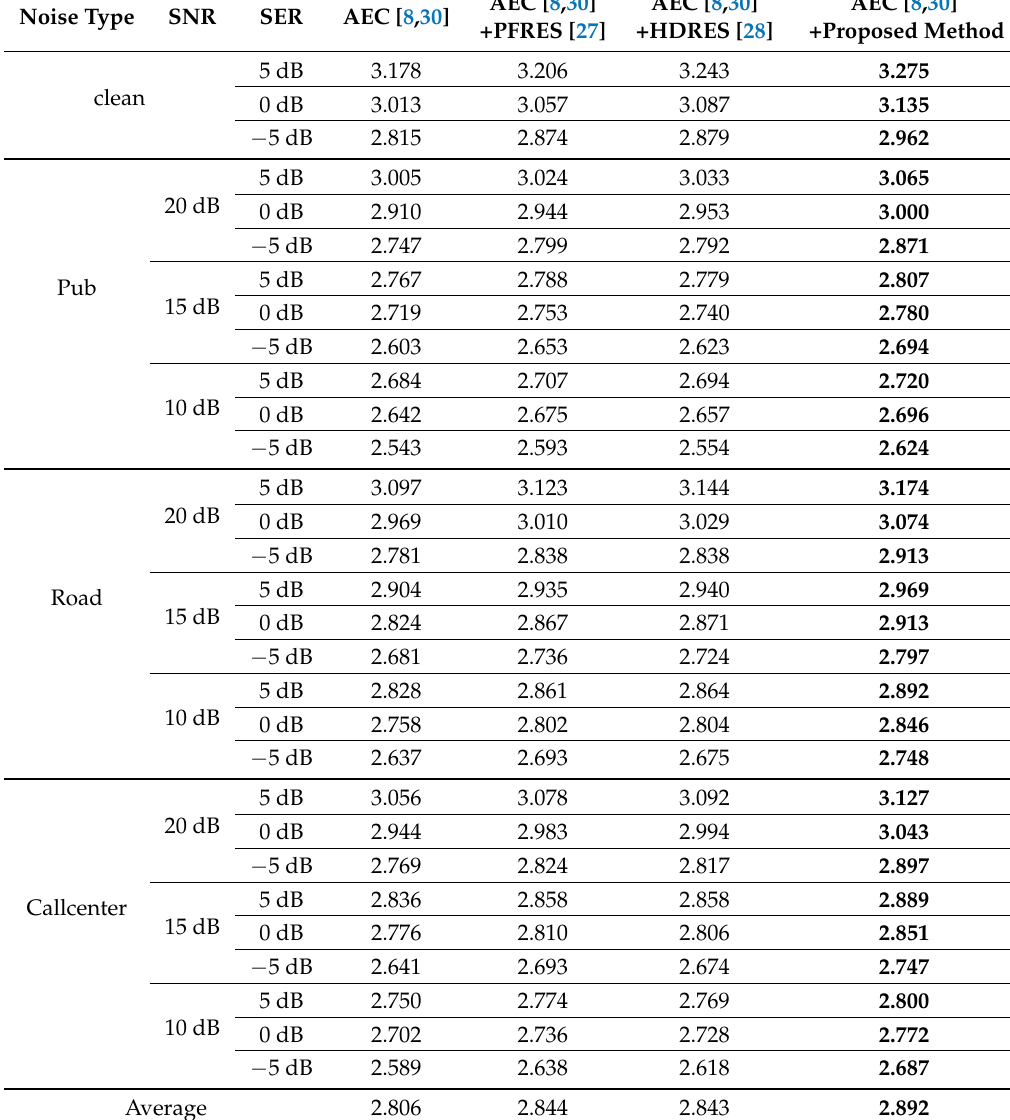
Table 4. Average PESQ scores in various SNR and SER conditions for the AEC without RES, with the PFRES [27], with the HDRES [28], and with the proposed RES during the double-talk periods for the real-recorded data. The numbers in the bold face indicate the best